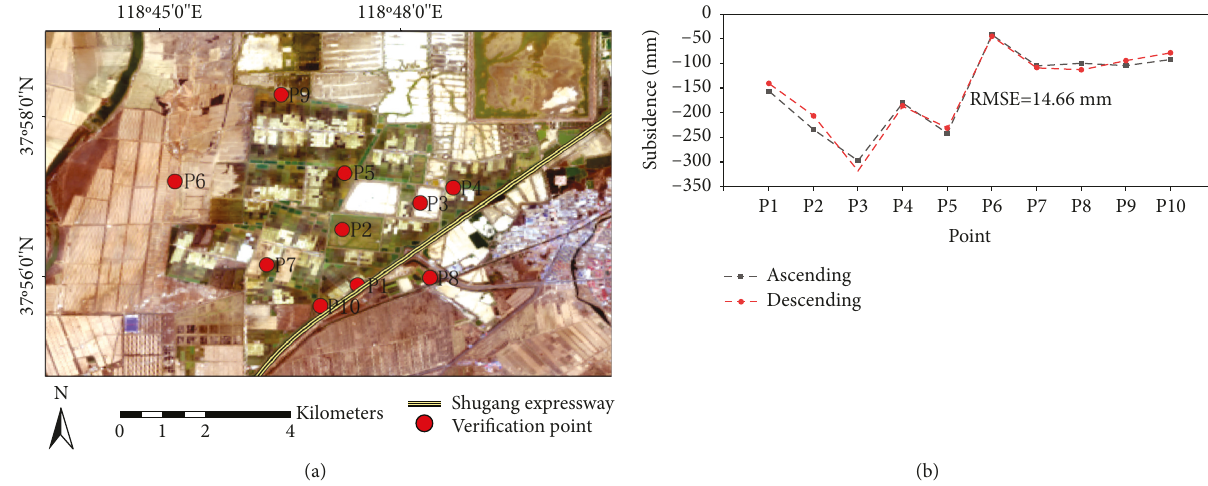
Figure 9: Validation results. (a) Location distribution of 10 validation points. Red circle indicates the validation point, and the number of the point is marked on the right side of circle. (b) Subsidence rate at each point. Black square denotes ascending Sentinel-1 datasets, and red circle denotes descending Sentinel-1 datasets.